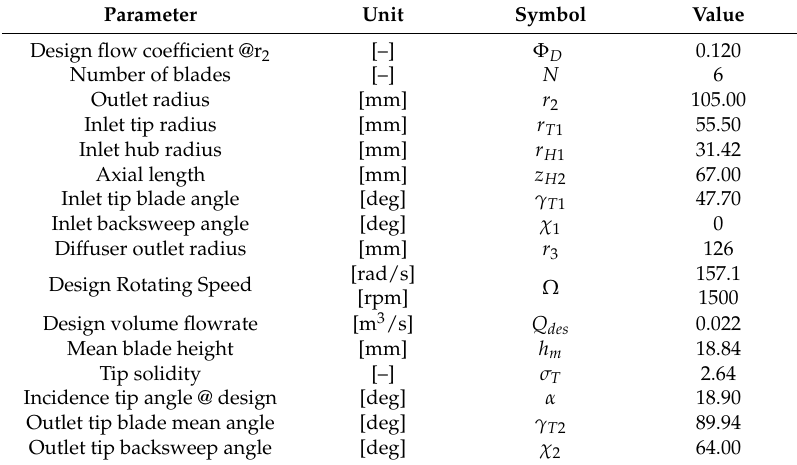
Table 3. Most relevant geometrical and operational parameters of the centrifugal